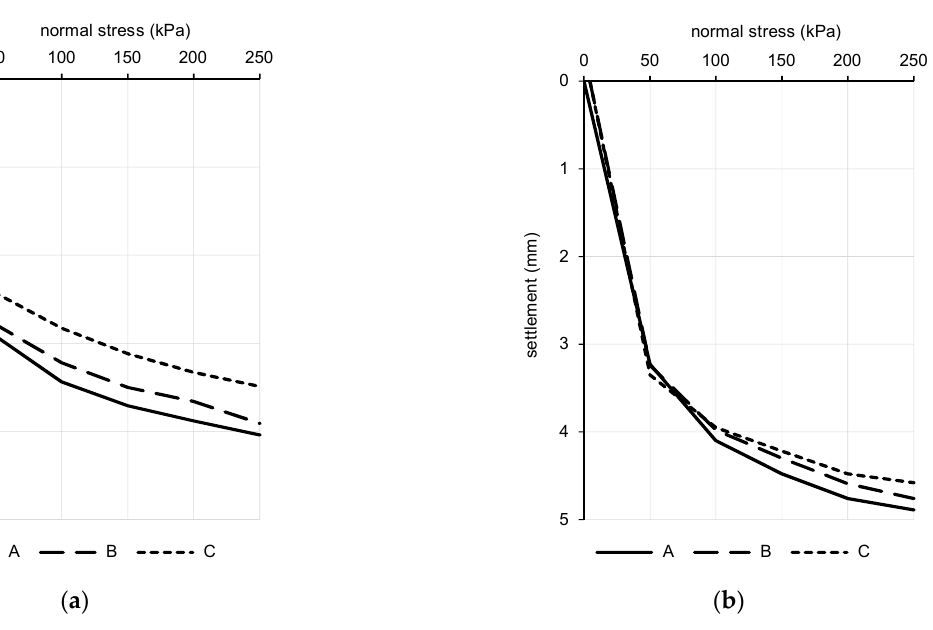
13 of 20 Figure 13. Kinetic sand after sliding. ( a ) Sample in the container; ( b ) Sample removed from the con- tainer with visible shear plane. 7. Results The results of the testing of the kinetic sand are presented in the following sections. 7.1. Density Tests The final minimal and maximal bulk density of the sand is calculated as an average value from two concurrent determinations if the difference is less than 50 kg·m − 3 . This condition was fulfilled. In the case of the original sand, the average minimal and maximal bulk density is 918 kg·m − 3 and 1560 kg·m − 3 , respectively. In the case of the boiled sample, the average minimal and maximal bulk density is 831 kg·m − 3 and 1431 kg·m − 3 , respectively.